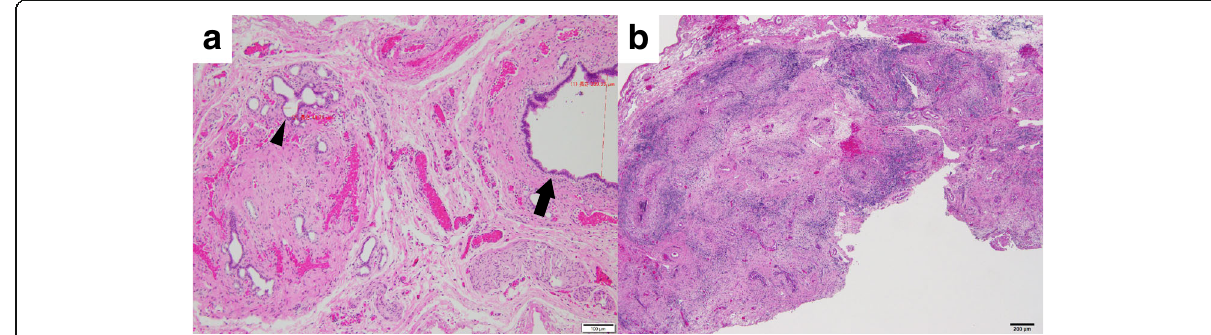
Fig. 3 Histopathological findings (hematoxylin – eosin staining). a Common hepatic duct and cystic duct. The diameter of the cystic duct was 300 μ m (arrow), while the common hepatic duct was closed and only bile ductules with a diameter of less than 50 μ m were isolated (arrowhead). No apparent inflammation was observed around the cystic duct. The scale bar represents 100 μ m. b Connective tissue in the porta hepatis. Severe infiltration of lymphocytes was detected. The scale bar represents 200 μ